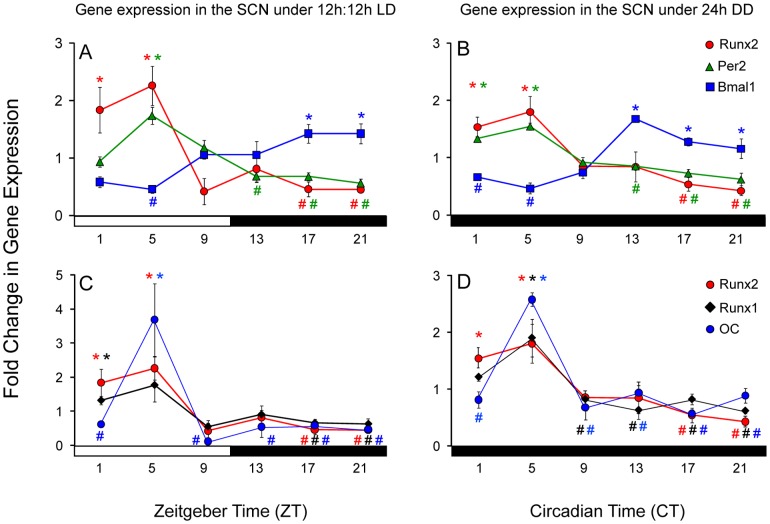
Runx2 gene expression is rhythmic in the SCN of wild type mice.Fold changes in levels of gene expression (± SEM) in the SCN for Runx2 (red circle), Per2 (green triangle; A and B), Bmal1 (blue square; A and B) and Runx1 (black diamond; C and D) and OC (blue circle; C and D) determined by real-time qRT-PCR under 12 h∶ 12 h LD (A and B) and 24 hr DD (C and D). Values represent the level of normalized gene expression relative to the mean overall normalized gene expression across the day. In 12∶12 h LD conditions, time of day is represented by white and black horizontal bars indicating periods of day (light) and dark (night), respectively, with dark onset marking ZT12. In 24 h DD conditions, black horizontal bars represent darkness during subjective day and night with running wheel activity onset marking CT12. Runx2 gene expression data for 12∶12 h LD and 24 h DD were plotted in both panels to allow for comparison with multiple gene profiles. Significant peaks levels of expression (*) compared to nadir points (#) for given gene presented in respective color (p<0.05).